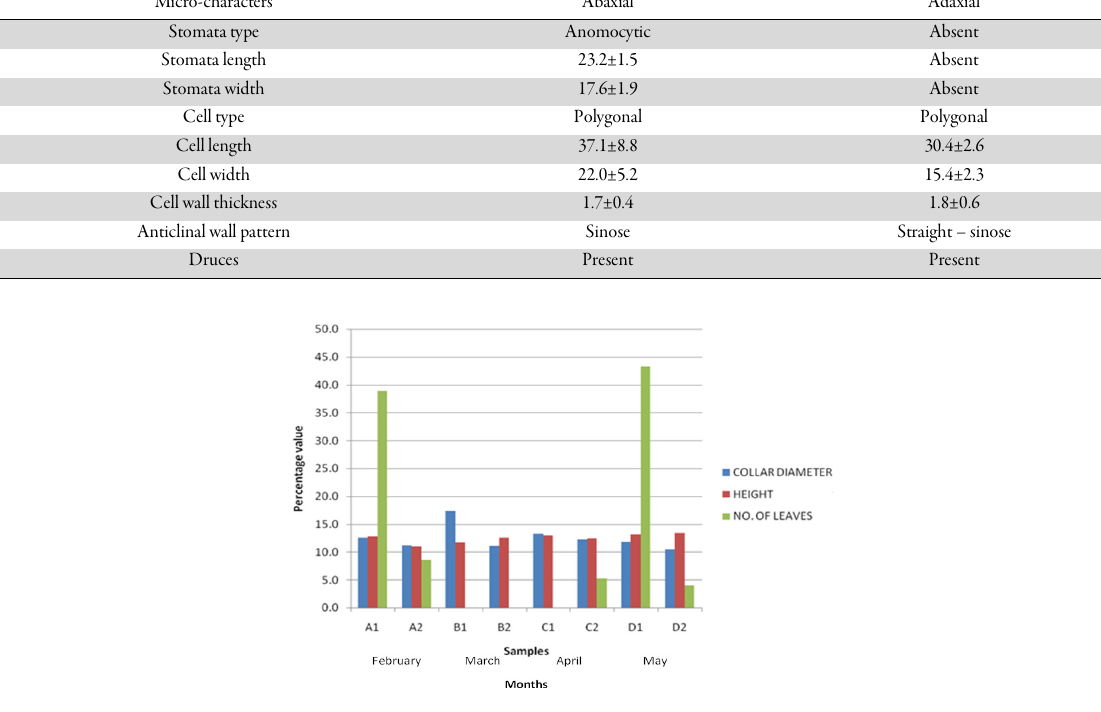
Fig 2. Percentage value of the different substrates across the various growth